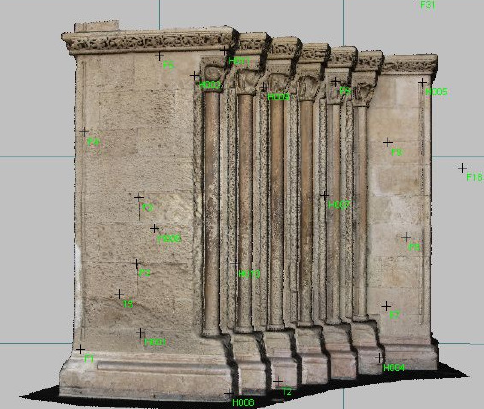
Figure 5: Textured sub-mesh of the columns